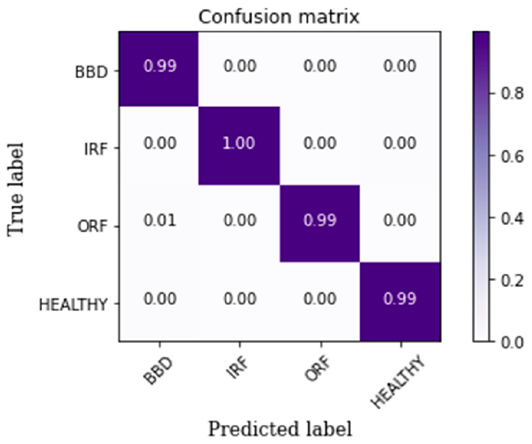
Figure 9. Confusion matrix for the proposed TL-based FD model. Table 2. Performance metrics of the proposed model.